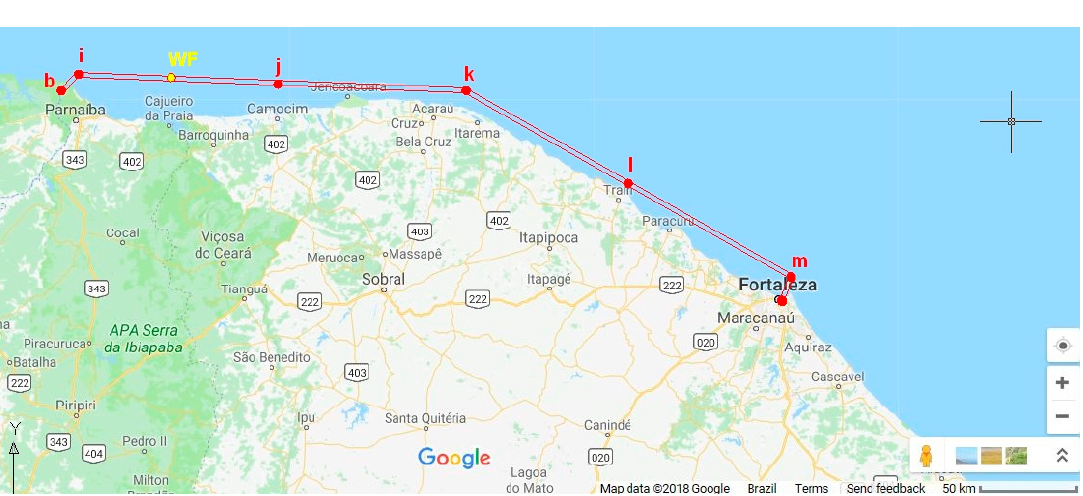
Figure 2. Location of the pipeline Parnaíba/Fortaleza, Brazil; letters in bold mean pumping units. WF is the location of the wind power plant. Map source: [47].